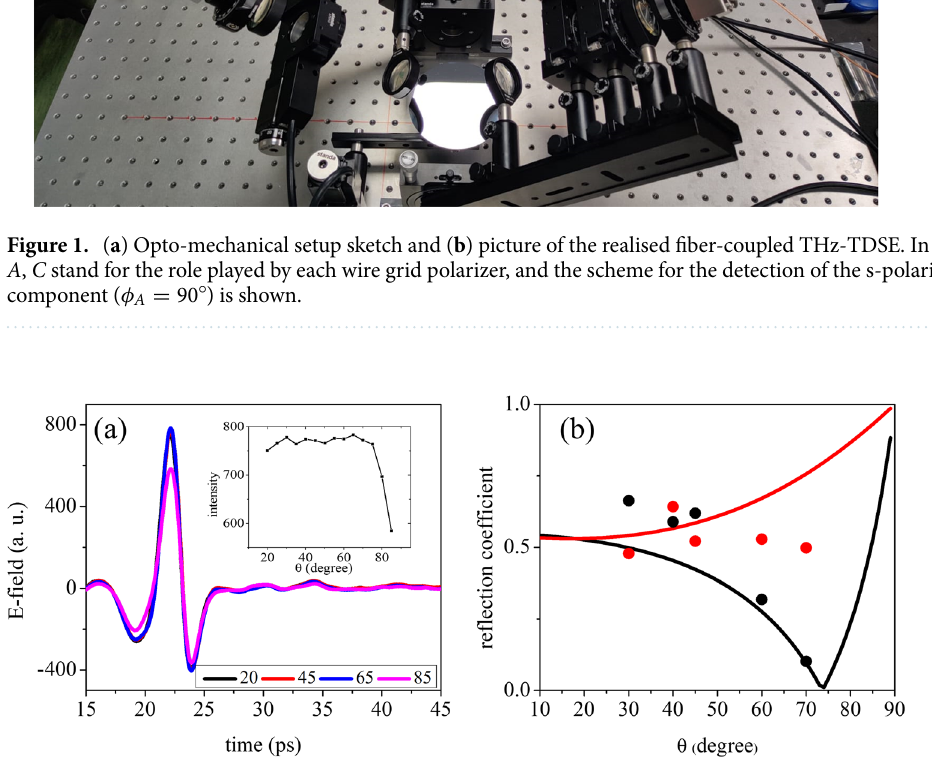
Figure 2. ( a ) Time profile of the electric field recorded by the THz-TDSE after the beam is reflected from the gold reflector at different angles. Signals all overlap but for θ = 85 ◦ . Inset shows the electric field peak intensity versus θ . ( b ) Expected r p and r s behavior for high resistivity Silicon (black and red continuous curves respectively) in comparison with experimental values (black and red full circles) as a function of the incident angle for the uncalibrated setup at 0.4